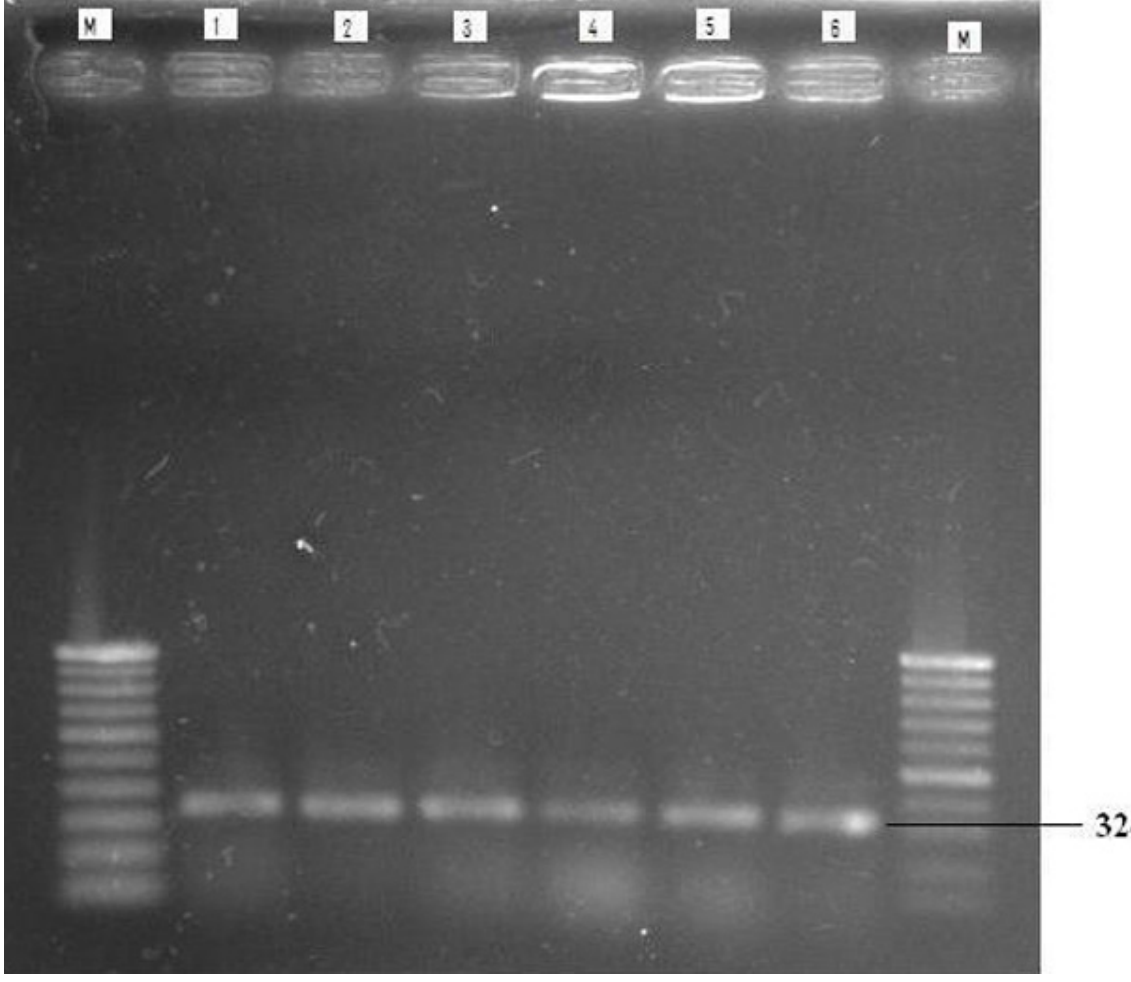
Figure 1. Detection of a toxin ( cpa ) gene in C. perfringens by PCR. Lane M: 100 bp molecular marker; lanes 1 to 5: C. perfringens field isolates; lane 6: known strain of C. perfringes bearing α toxin